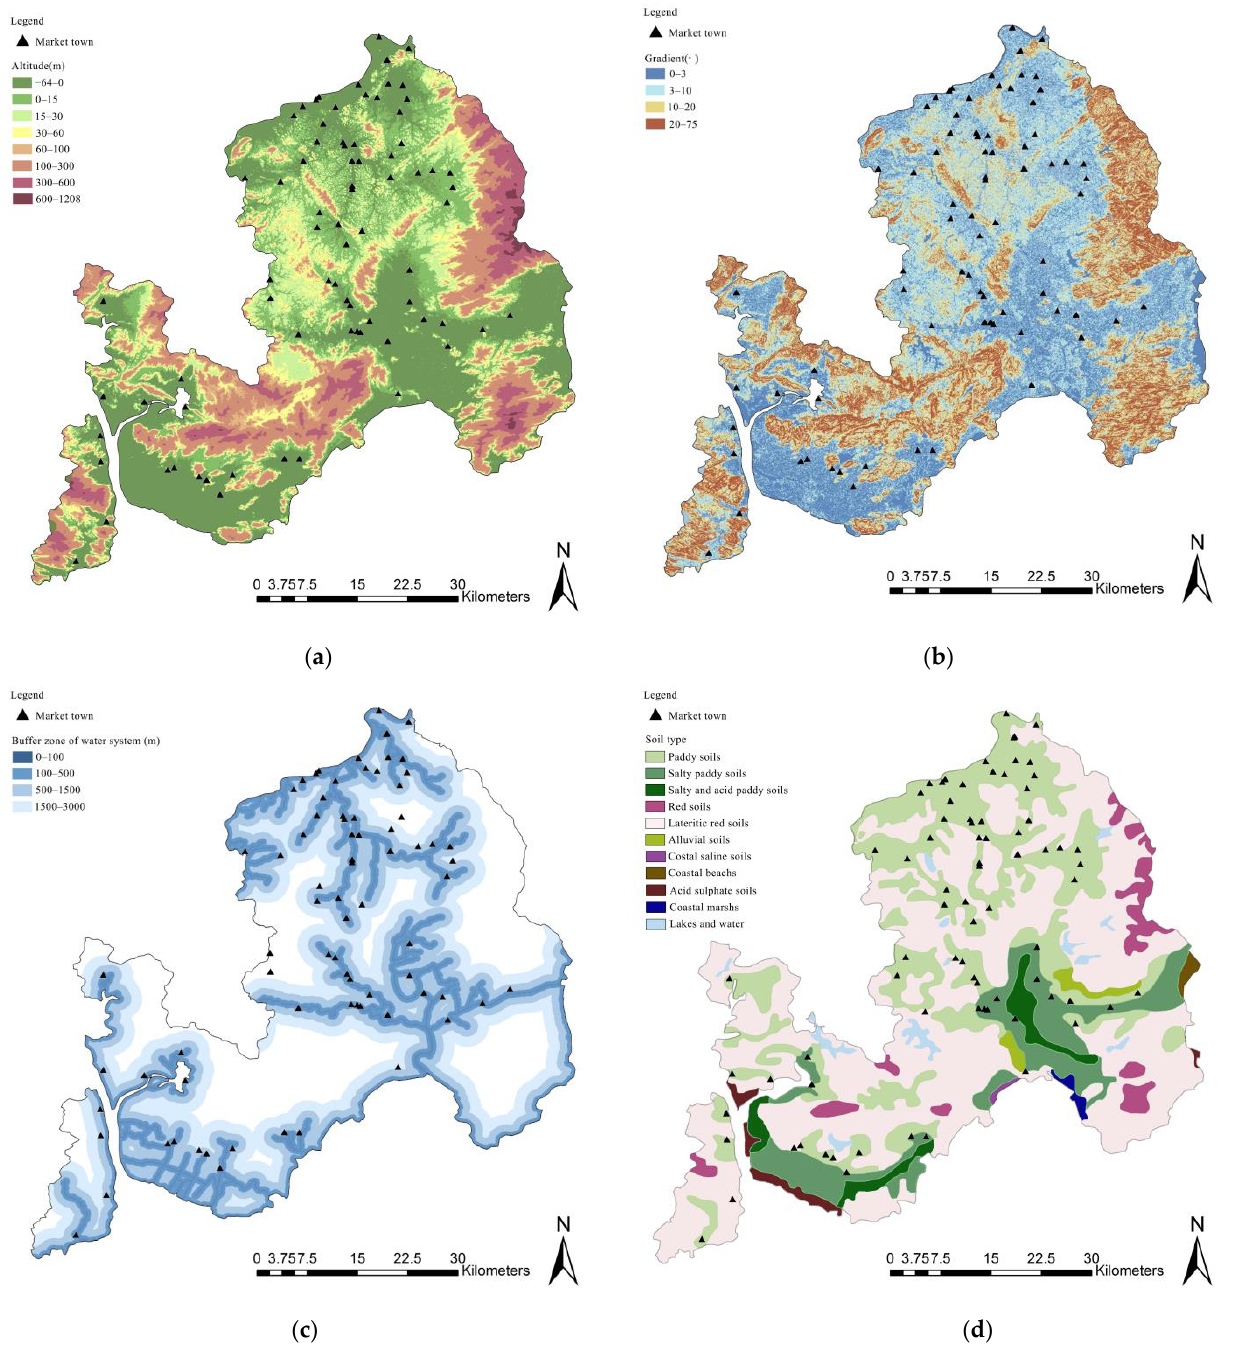
Figure 3. Physical environmental factors and market town distribution. ( a ) Elevation classifications; ( b ) slope classifications; ( c ) water system buffer zone classifications; ( d ) soil classifications. Table 2. Statistics of market towns in different classifications of elevation, slope, and water buffer zones in Taishan.